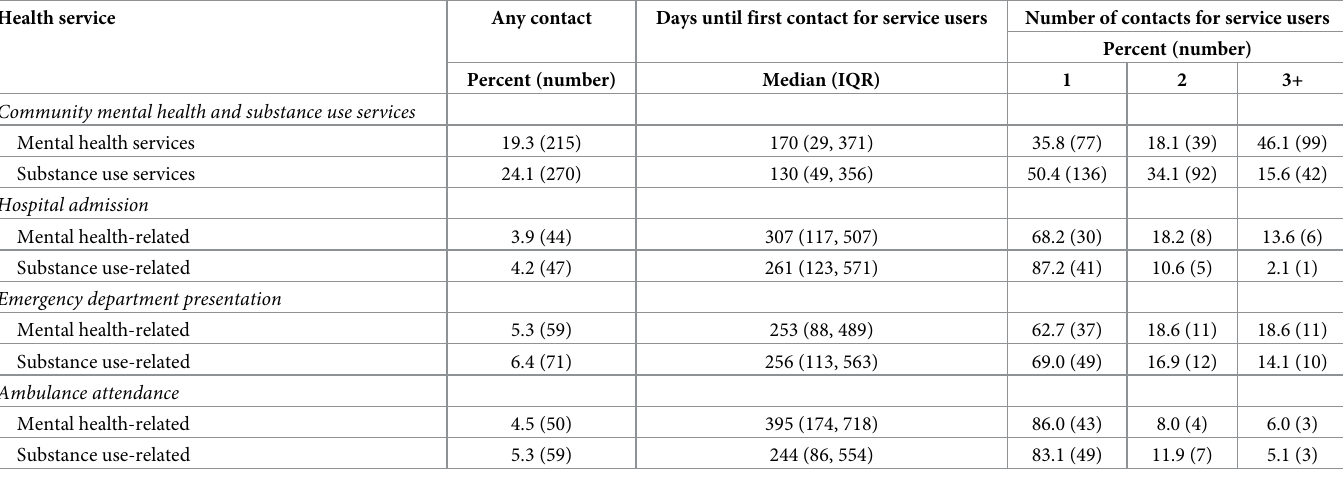
Table 2. Summary of health service use for mental health and substance use problems during follow-up.